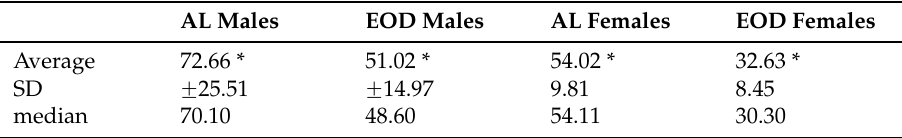
Table 4. Hepatocyte nuclear area ( µ m 2 ) of animals on EOD diet and AL fed.